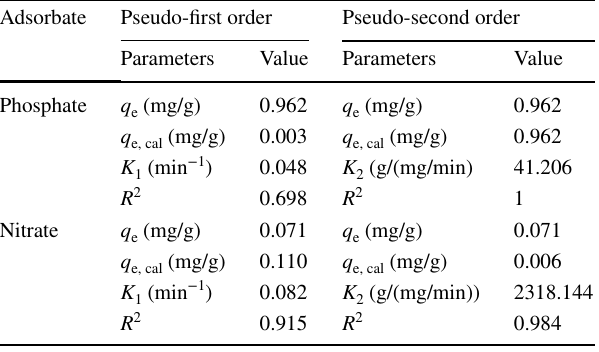
Table 1 Parameters of pseudo-first- and pseudo-second-order adsorp- tion kinetics of phosphate and nitrate